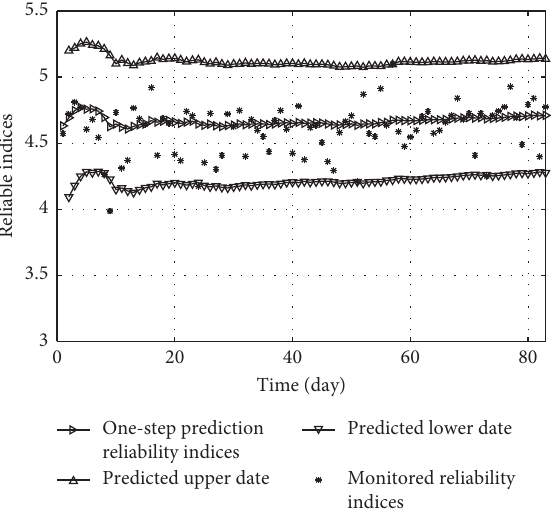
Figure 9: Predicted bridge reliability indices.